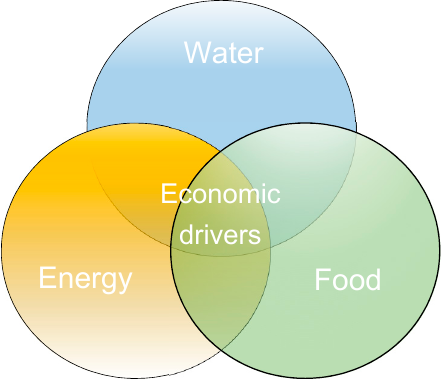
Figure 6. Methodological framework for rural electrification in Mozambique with a local nexus approach. Source: own illustration.